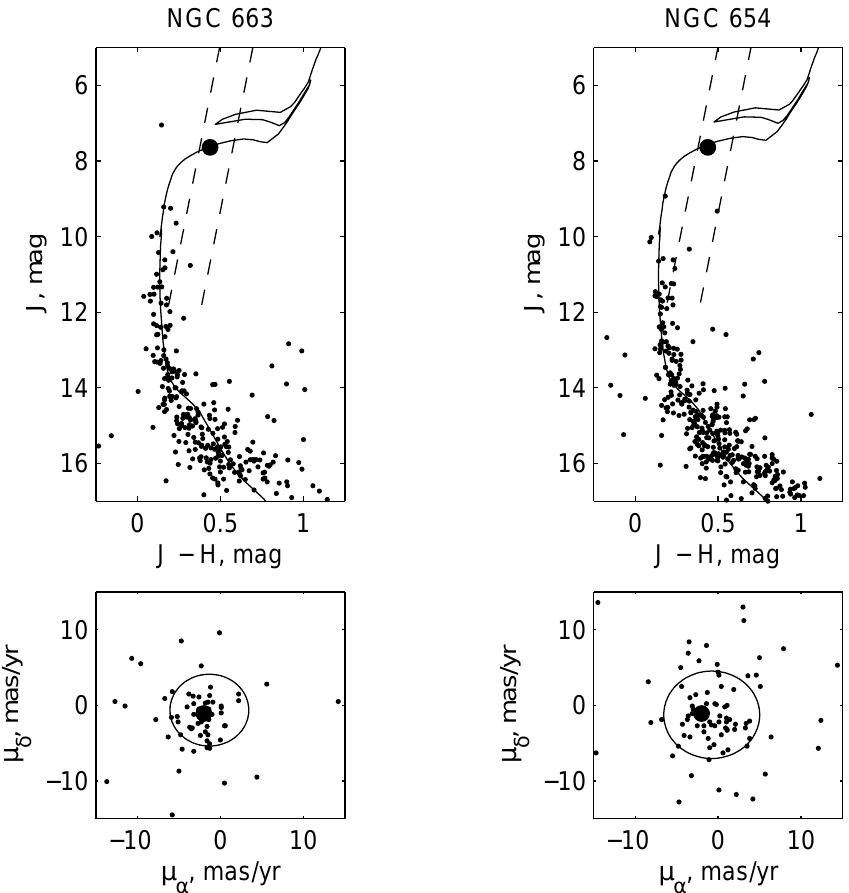
Fig. 1. The color{magnitude diagrams and proper motion distributions in the 5- arcmin (cid:12)elds of the clusters NGC 663 and NGC 654. The large solid dot is the Cepheid BY Cas. The NGC 663 CMD is (cid:12)tted using the isochrone with log t = 7 : 9, E J (cid:0) H = 0 : 19 mag, J (cid:0) M J = 12 : 06 mag; the NGC 654 CMD, using the isochrone with log t = 7 : 9, E J (cid:0) H = 0 : 19 mag, J (cid:0) M J = 12 : 00